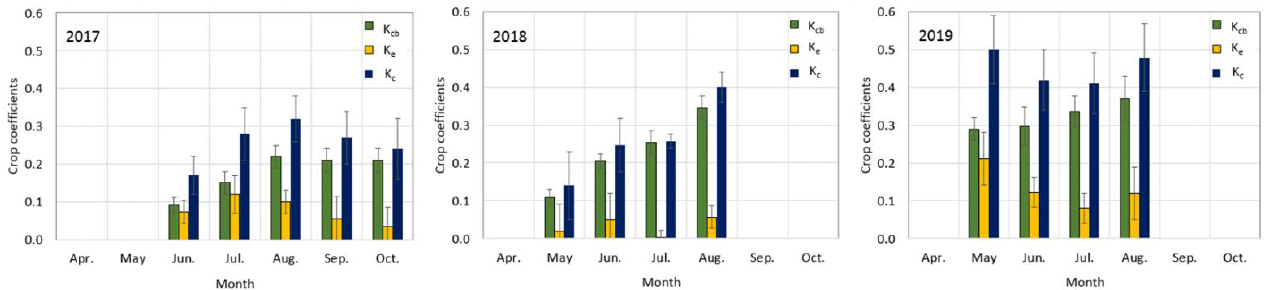
Figure 11. Monthly mean values of the crop coefficients (K c , K e , and K cb ) for the 2017–2019 growing seasons. Error bars correspond to the standard deviation of the monthly averages.